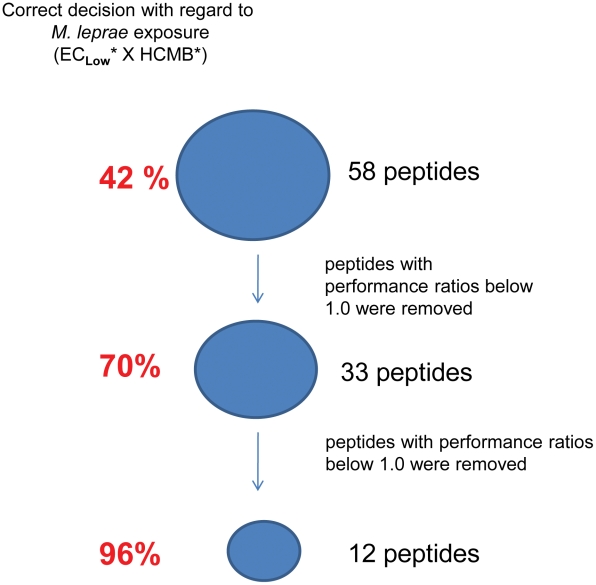
Selection of M. leprae-specific peptides.Fifty-eight M. leprae-specific peptides were previously tested for induction of IFN-γ release by PBMC from leprosy patients and contacts, endemic and non-endemic controls [13]. The IFN-γ levels induced by the peptides in non-exposed (EClow) and M. leprae-exposed individuals (HCMB) were used for selecting the best set of peptides allowing discrimination of the exposed group by applying an ANN algorithm. The final 12- peptide ANN made the right choice in 96% of the tests, identifying M.leprae-exposed or non-exposed individuals. *, individuals recruited from the city of Rio de Janeiro.